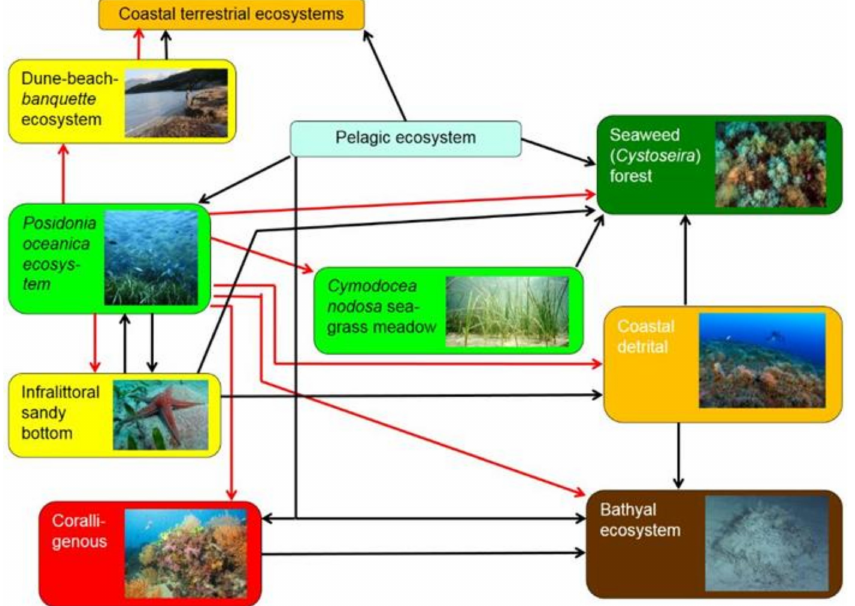
Figure 12. Some interactions between Mediterranean coastal ecosystems. Red arrows: export of litter. Black arrows: other carbon and nitrogen flows. Other interactions are not shown, e.g., nurseries and spawning